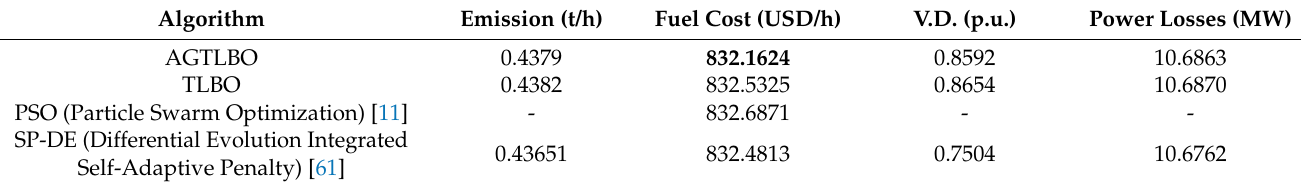
Table 6. Optimal results by different algorithms for Case